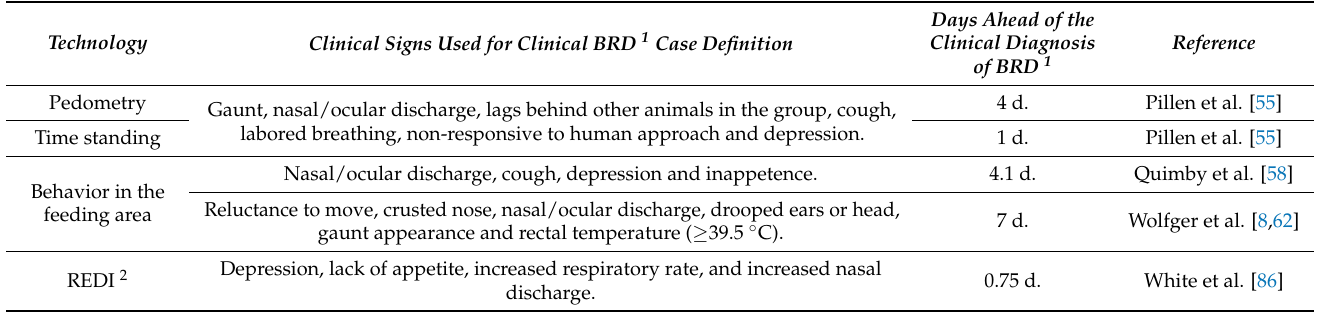
Table 3. Summary of the days prior to the clinical diagnosis of BRD cases using technology compared to the clinical diagnosis based on BRD clinical